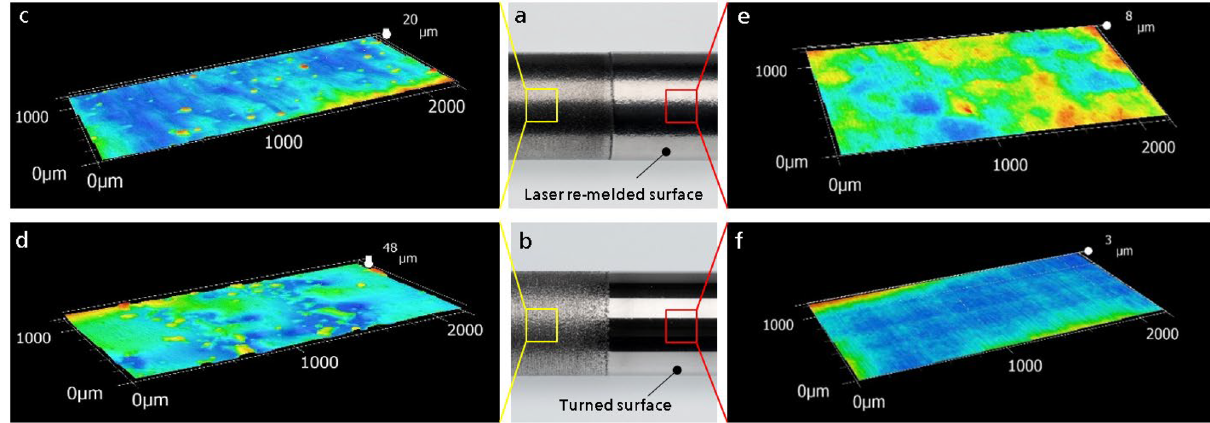
Figure 2. The topography of the coated and the post-processed surfaces. ( a , b ) Two tubes, which are coated and afterwards partially post-processed by laser re-melting (upper) and turning (lower), respectively. ( c , d ) The surface topography of the surfaces after coating. ( e , f ) The surface topography of the post-processed surfaces by laser re-melting and turning, respectively. It can be seen, the surface roughness can be essentially improved by both post-processing methods.